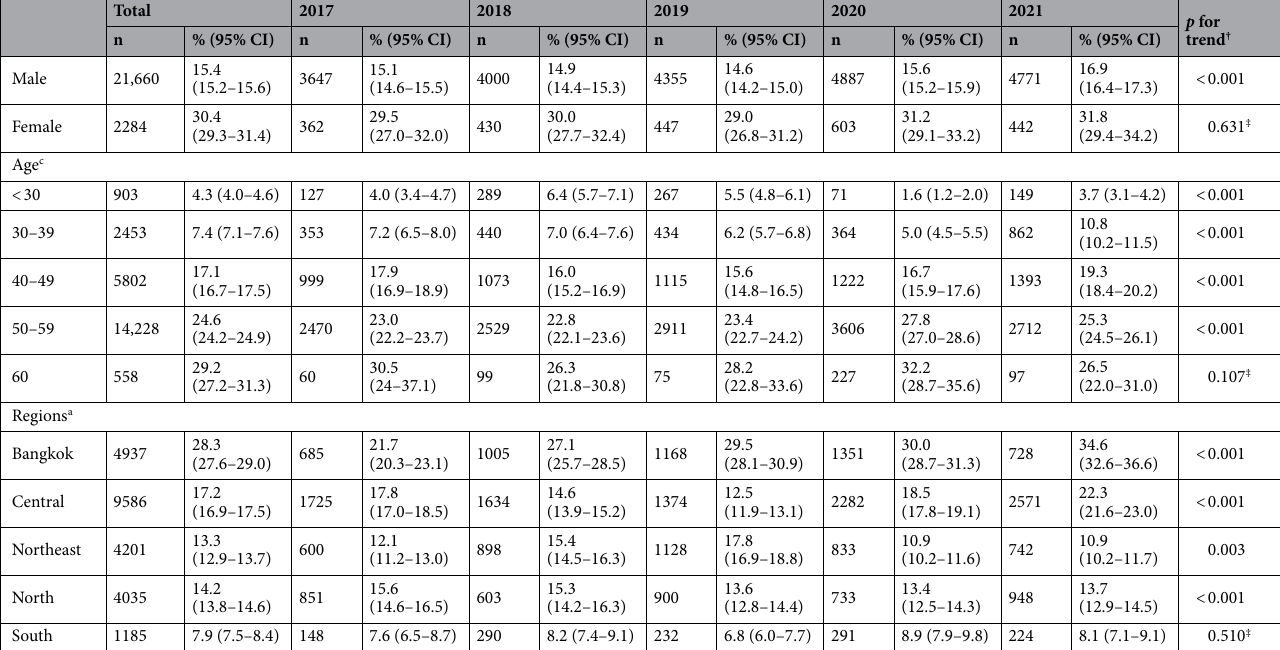
Table 3. Trends in age- and sex- adjusted prevalence, awareness, and control of hypertension among RTA personnel from 2017 to 2021. SBP systolic blood pressure, DBP diastolic blood pressure, 95% CI 95% confidence interval. † Nonlinear trend was tested first by adding a quadratic term into the regression model. If not significant, linear trend was tested. ‡ Linear trend. a Age- and sex-adjusted prevalence. b Age-adjusted prevalence. c Sex-adjusted